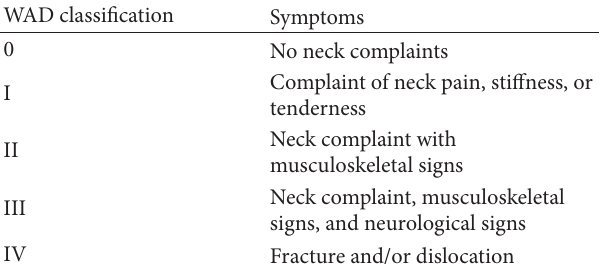
Table 4: Summary table of the Whiplash-Associated Disorder (WAD) classifications and concussion symptoms that can manifest themselves in any grade of WAD [6, 20, 27,